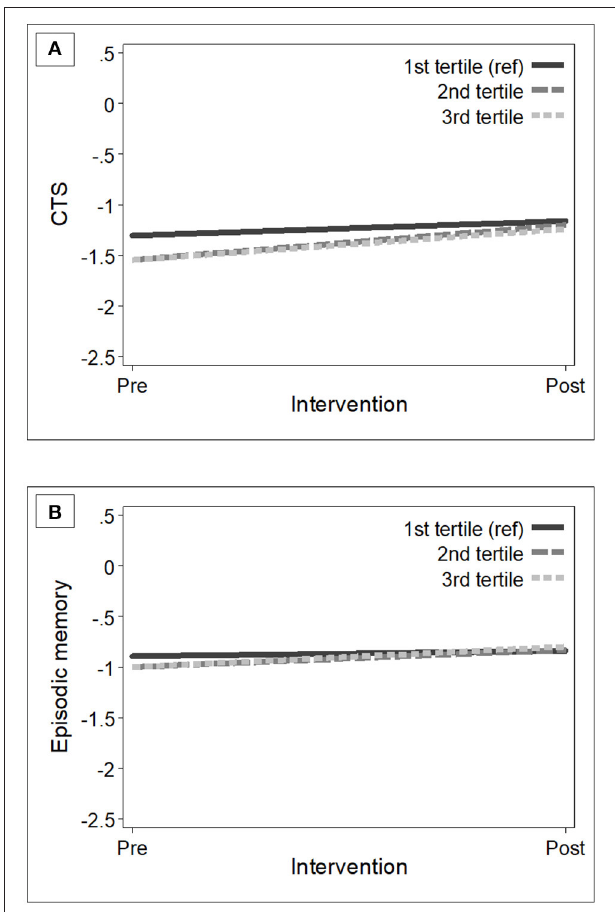
FIGURE 2 | Estimated trajectories of change in global cognition (A) and episodic memory (B) among participants in the intervention group ( n = 638) with low (first tertile, reference) to high (third tertile) adherence levels to the NU-AGE dietary intervention. Mixed-effect models were adjusted for baseline age, sex, education, country, and interviewer. The trajectories were plotted using the mean values of the covariates. CTS, CERAD total